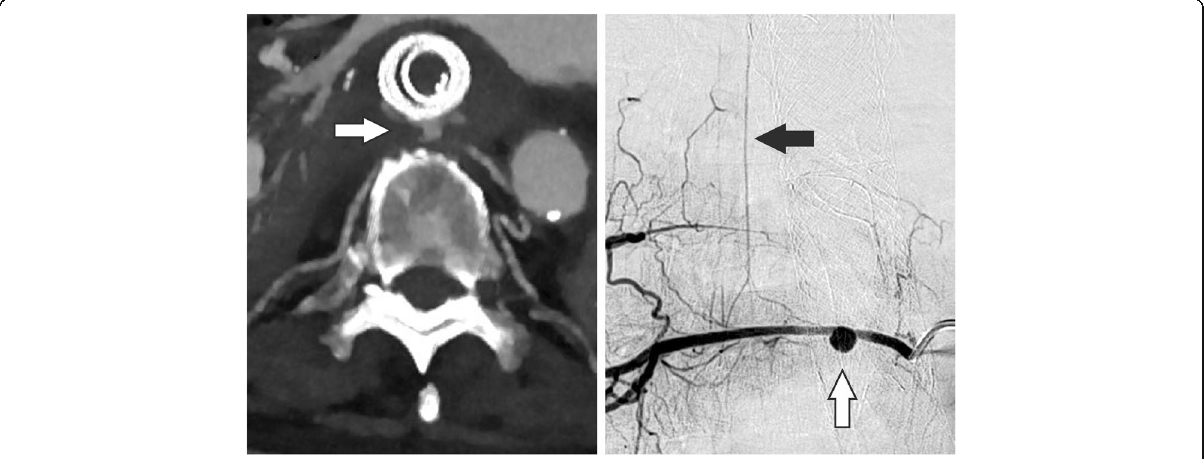
Fig. 1 DSA and CT scan before implantation of the PK Papyrus Stent. In the CT scan the pseudoaneurysm can be detected ventral of the spine with direct contact to the esophagus. Furthermore, the previously implanted, esophageal stents can be seen. The esophageal tissue seems to be thinned out. After the CT scan, the DSA confirms the suspected pseudoaneurysm and shows the connection between the intercostal artery and the anterior spinal artery. White arrow: Pseudoaneurysm of the intercostal artery. Black arrow: Anterior spinal